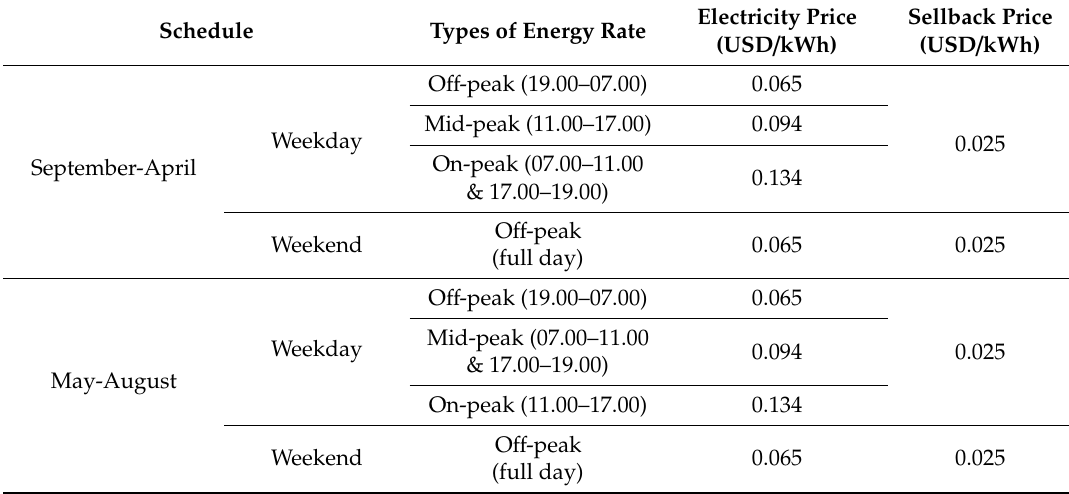
Table 6. Energy rates of the electric grid